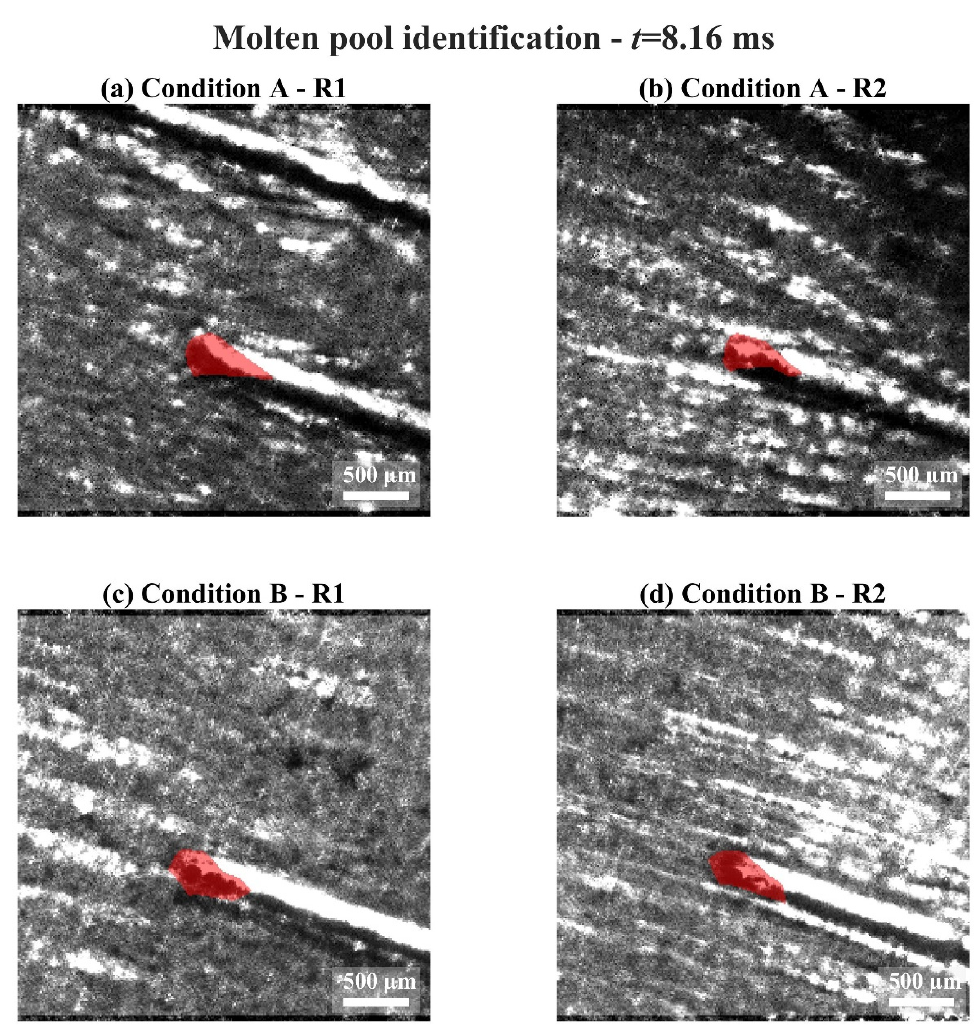
Figure 7. Single frame from the high-speed imaging acquisition with coaxial imaging and off-axis illumination in the different conditions of the experimental design.. Molten pool identified via image processing algorithm highlighted in transparent red. The reader is referred to Supplementary Video S2 to appreciate the dynamic effects of the acquisition.